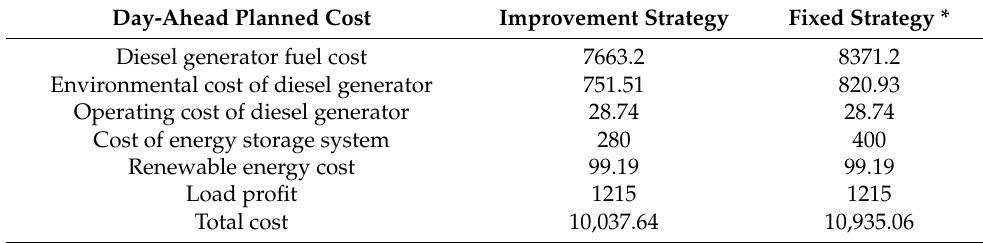
Table 3. Economic